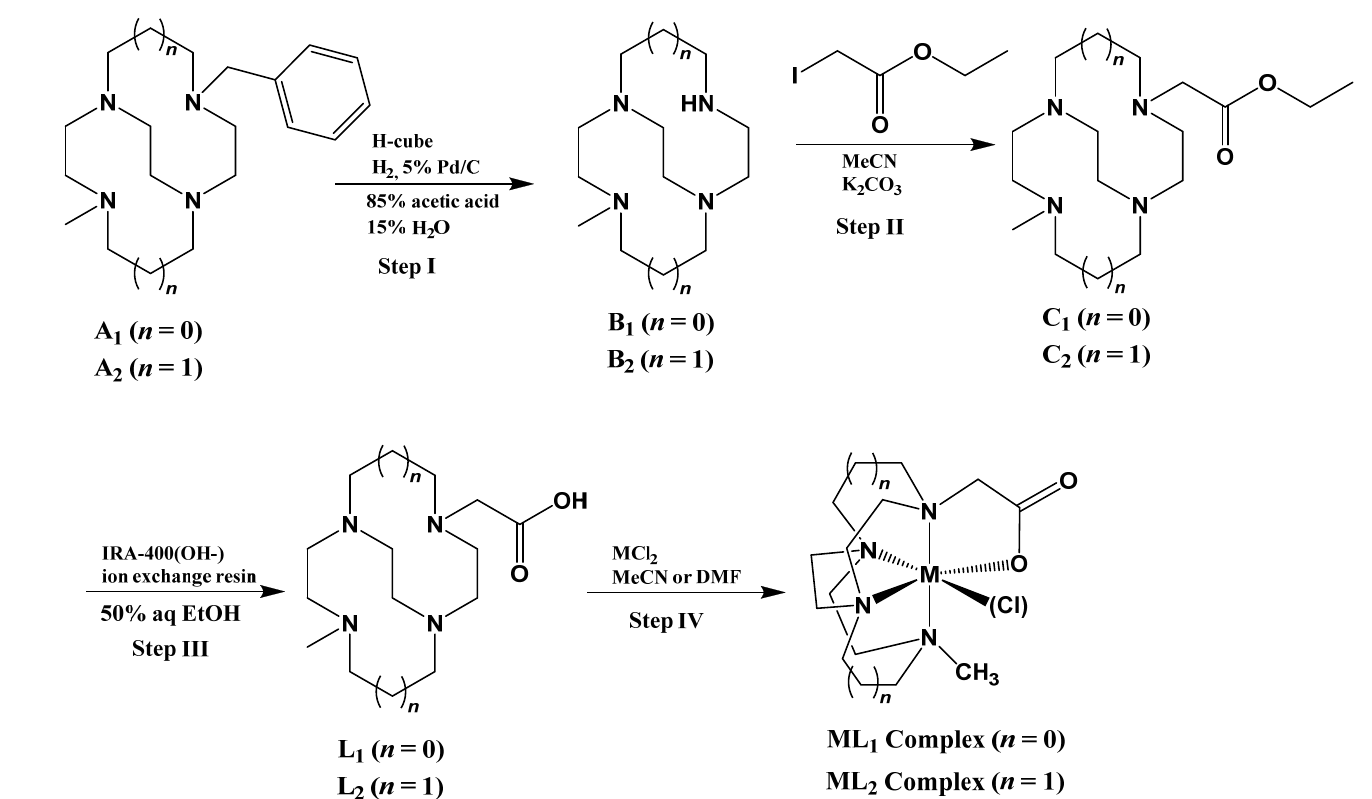
Scheme 1. Combined synthetic scheme for the synthesis of L 1 , L 2 , and their metal